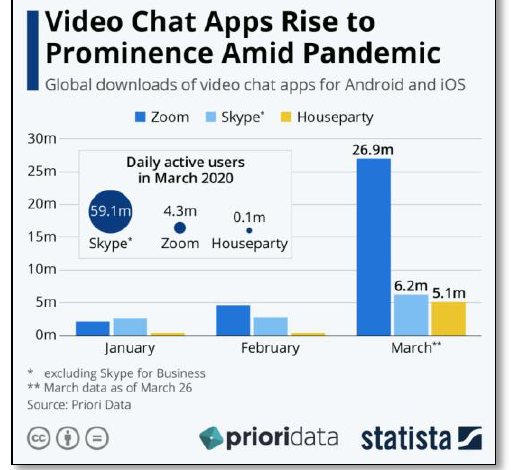
Fig. 1. Statistics on Video Chat Application due to COVID 19 Pandemic